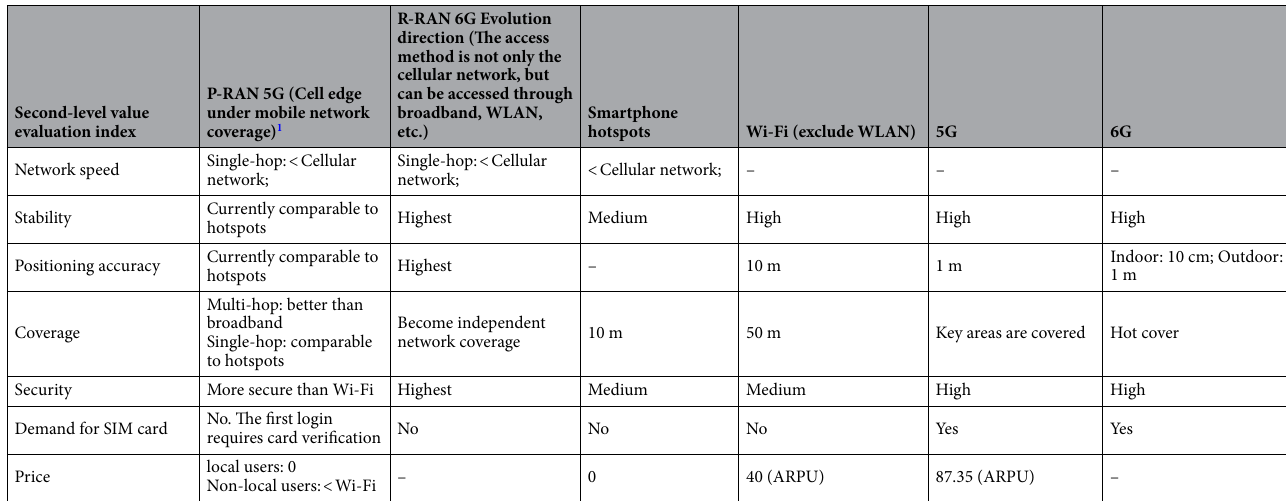
Table 3. P-RAN, hotspot, broadband, mobile network (5G/6G) performance comparison. Description of "High-Medium–Low" grading standard: The grading standard of each indicator capability is